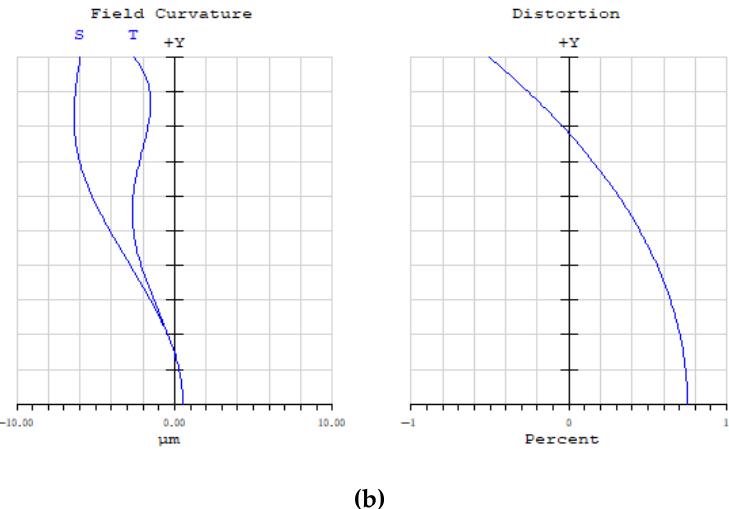
Figure 6. ( a ) The modulation transfer function (M.T.F.) and ( b ) the field curvature and distortion of the designed f-theta lens group.